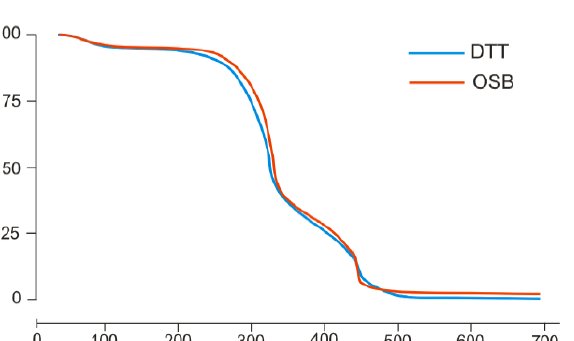
Figure 8. Comparison of thermogravimetric records showing the decomposition of selected board materials at a heating rate of 10 °C.min − 1 in an atmosphere of air.